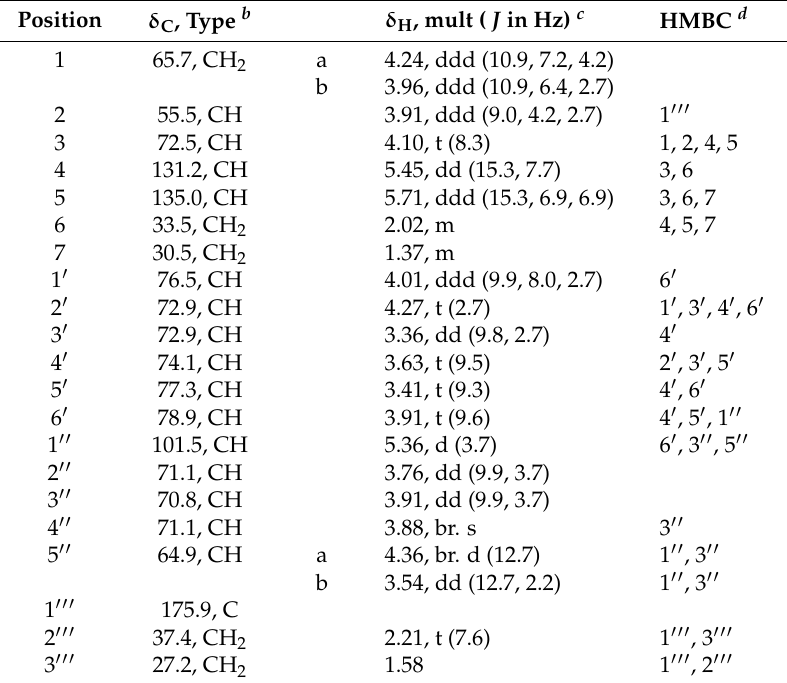
a NMR data of minor homologues with a saturated sphingosine. 1 H signals: H-1a: 4.28, ddd (10.9, 7.9, 3.8); H-1b: 3.91, m; H-2: 3.84, ddd (9.0, 4.2, 2.7); H-3: 3.67, br. t (8.0); H-4a: 1.56, m; H-4b: 1.35, m. 13 C signals: C-1: 65.9, CH 2